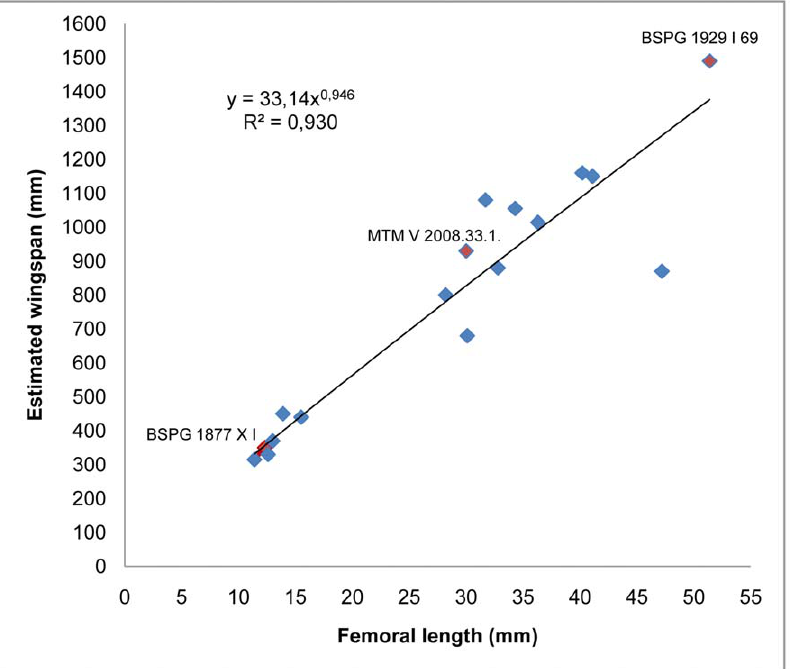
Figure 7. Plot and regression of femoral length vs. estimated wingspan of 17 Rhamphorhynchus specimens. Changes in the relation between these two traits during ontogeny can best be described by a power function in which high r 2 value (p=0.000) guarantees the reliability of the equation making wingspan estimations of specimens with missing wing bones possible.